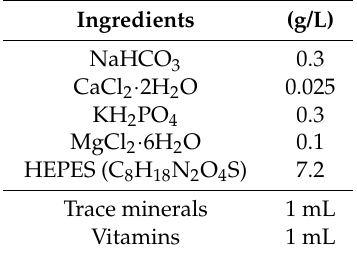
Table 1. The ingredients of growth medium.